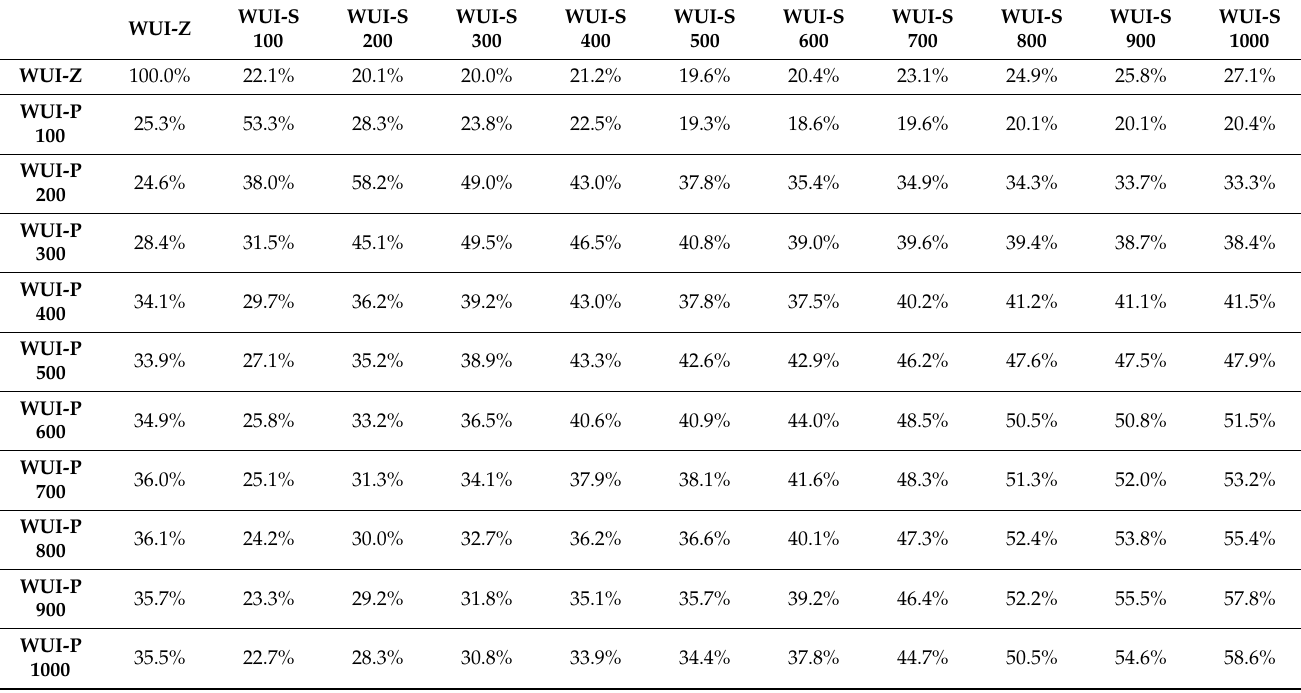
Table A2. Percent agreement between different types of